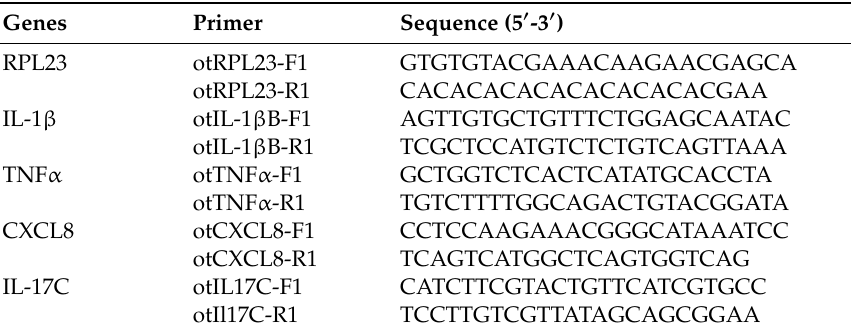
Table 1. Primers used in qRT-